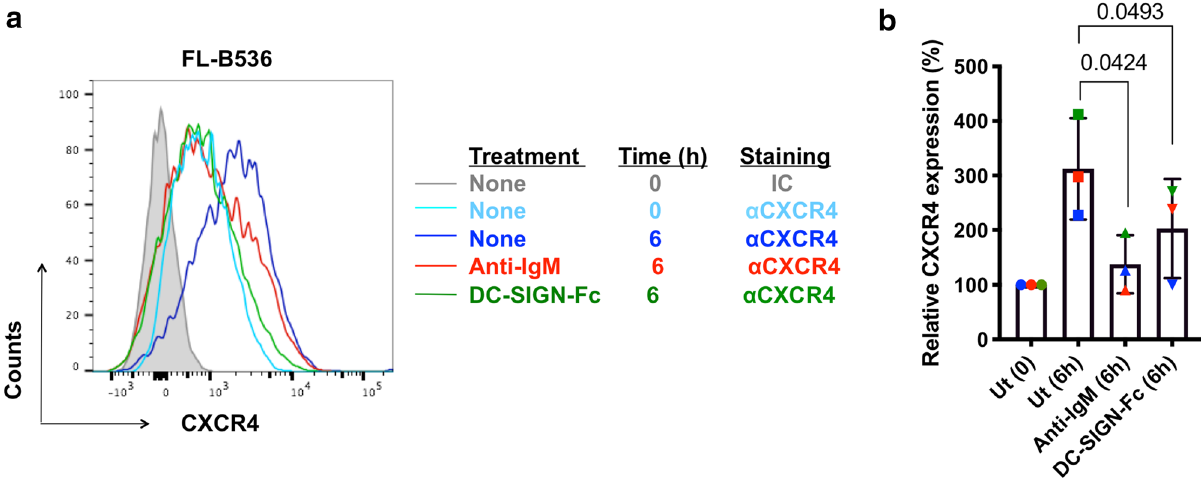
Figure 2. Regulation of CXCR4 expression in primary FL samples. ( a , b ) CXCR4 expression in CD10 + /CD20 + cells of FL samples FL-B536, FL-LY86 and FL-LY221 at the start of the experiment, or after 6 h of treatment with anti-IgM or DC-SIGN-Fc, or left untreated (Ut) as a control. ( a ) Representative results obtained using sample FL-B536 and ( b ) summary for all samples (n = 3) analyzed. The graph shows mean (± SD) relative CXCR4 expression with values for control cells at 0 h set to 100%. The statistical significance of the indicated differences is shown (Paired